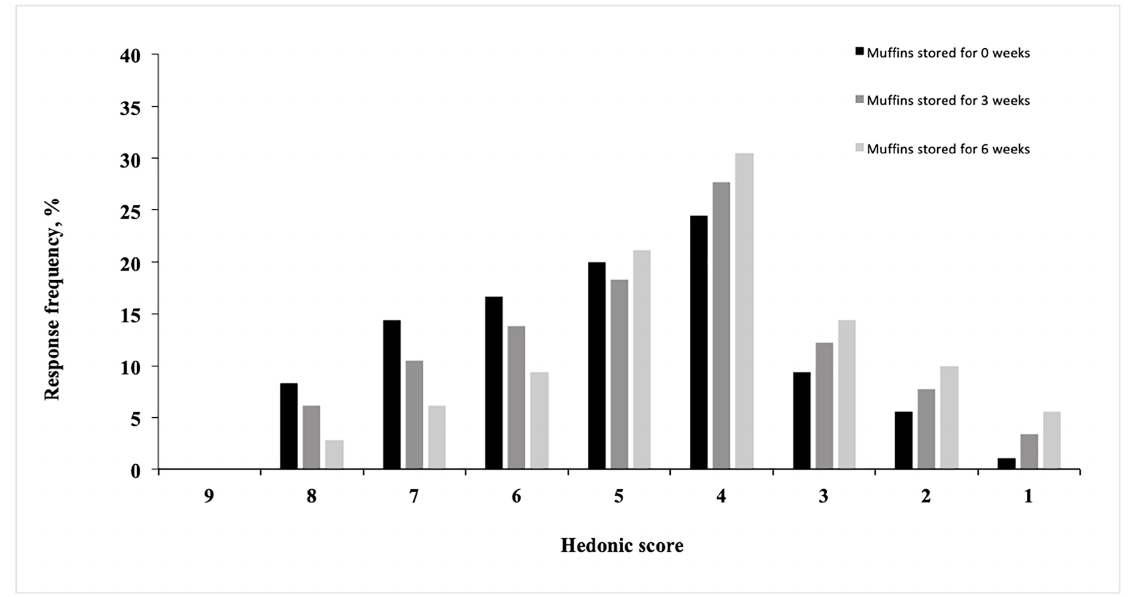
Figure 4. Distribution of individual preferences of mu ffi ns containing 0.075% of ChPE (chokeberry polyphenol extract): fresh mu ffi ns (0 weeks) compared with those stored for 3 and 6